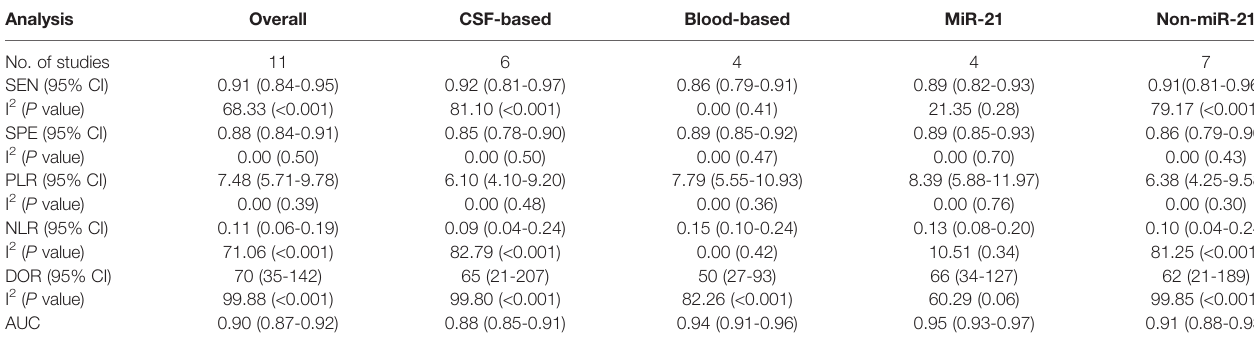
TABLE 2 | Diagnostic performance of miRNAs in patients with